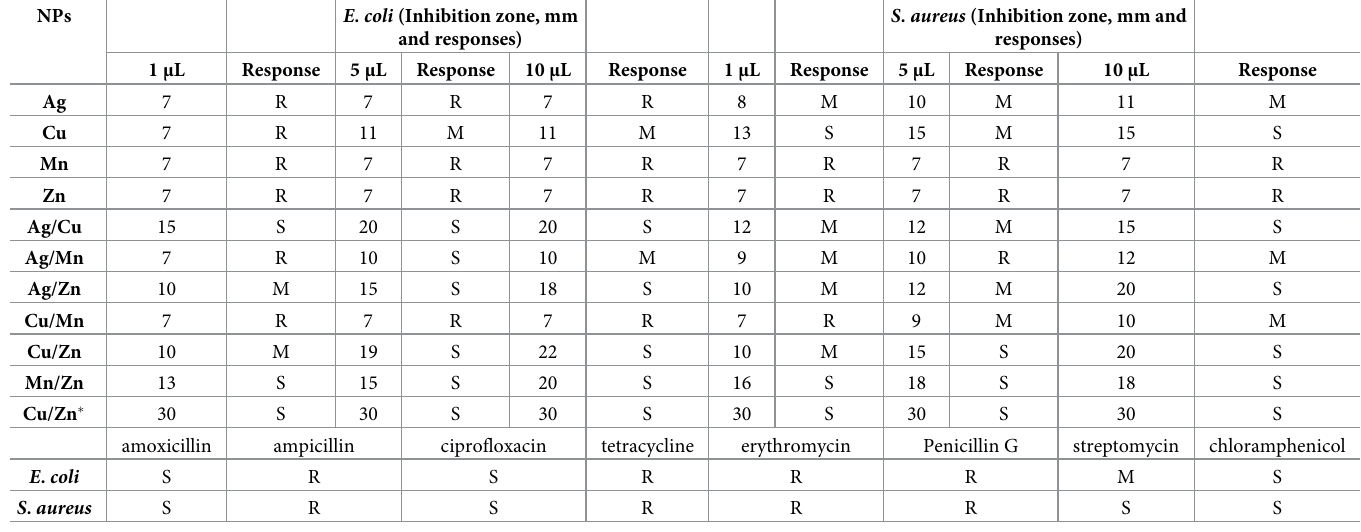
Table 1. Antimicrobial activity of antibiotics and Cu/Zn NPs biosynthesized from the secondary metabolite of a novel fungal strain Aspergillus iizukae EAN605 grown in pumpkin medium.